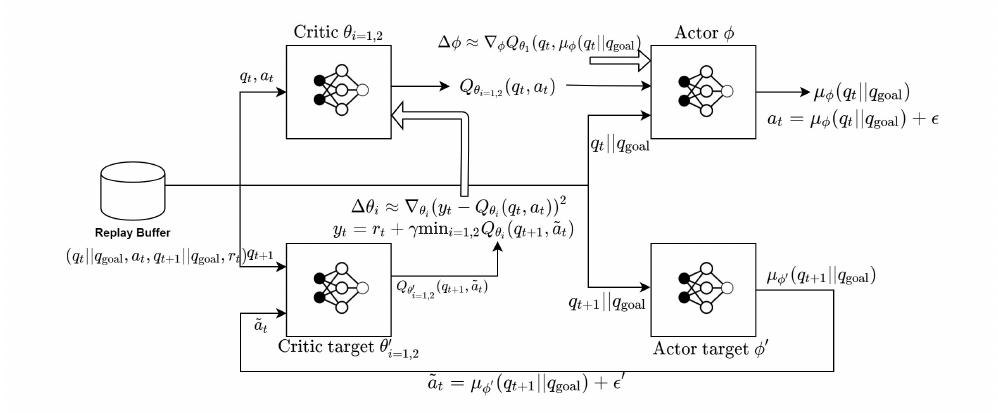
Figure 3. Details of critic and actor deep neural network for